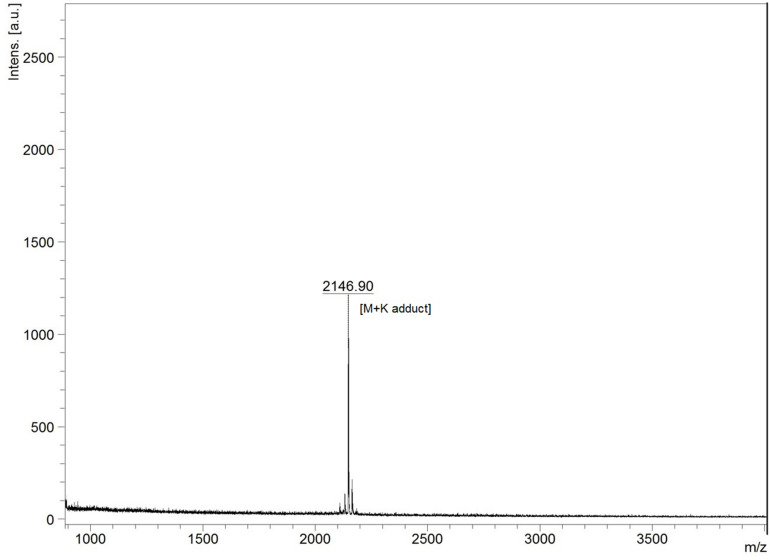
MALDI-TOF mass spectra of HPLC purified lantibiotic of B. clausii UBBC07. M + K indicates mass + potassium adduct (2107.94 + 38.96).